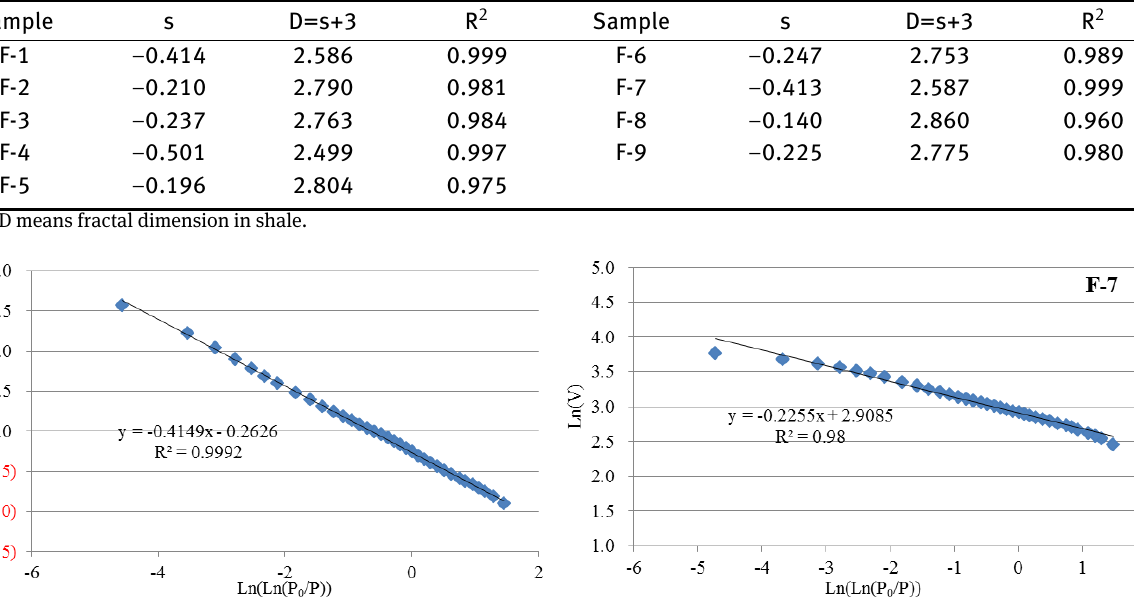
Figure 4: Fractal dimension fitting results of organic-rich shale FHH